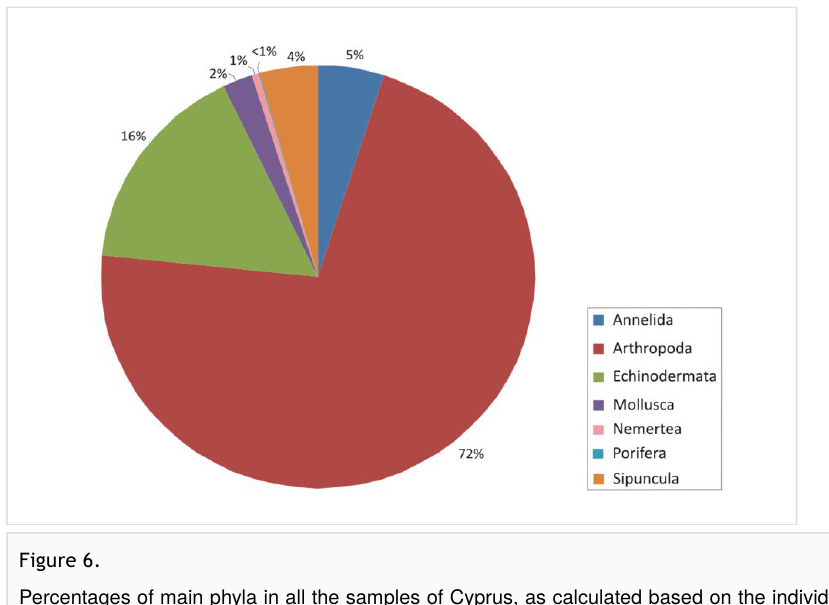
Figure 6. Percentages of main phyla in all the samples of Cyprus, as calculated based on the individual count of species per total sponge volume.